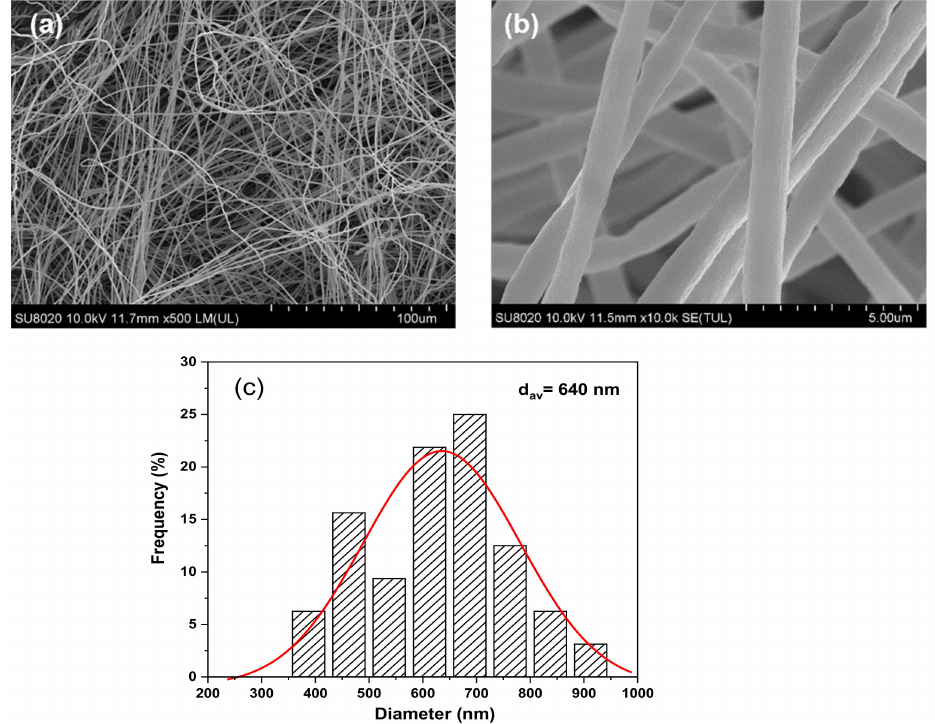
Figure 3. SEM micrographs of TPPI fiber veils in low resolution ( a ) and high resolution ( b ), and the calculated fiber diameters distribution ( c